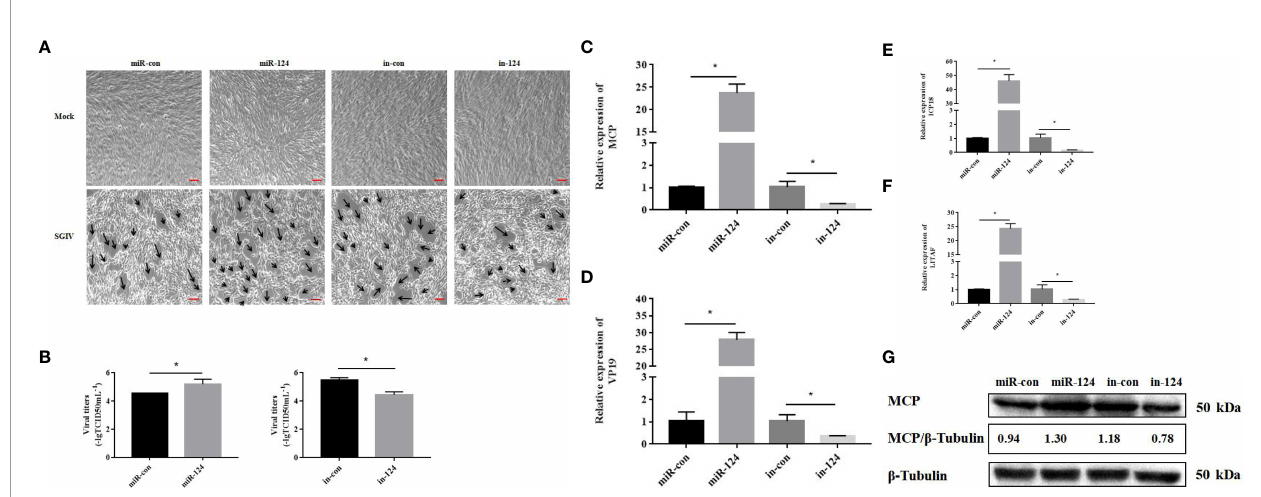
FIGURE 4 | Effect of miR-124 on virus infection and replication. (A) The cytopathic effect (CPE) of Singapore grouper iridovirus (SGIV)-infected miRNA-transfected GS cells, and the black arrows indicate the severity of CPE caused by SGIV infection at 24 h.The scale is 50 m m. (B) The viral titers in each group were measured using the TCID 50 method. Data are presented as mean ± SD, N = 3. (C – F) The expression levels of SGIV genes ( MCP , VP19 , ICP18 , and LITAF ). Data are presented as mean ± SD, N = 4. Compared with the control group, signi fi cant difference of experimental group is indicated with *( P < 0.05). (G) The level of SGIV MCP proteins was detected by Western blotting, the band intensity was calculated, and ratios of target protein/ b -tubulin were assessed by ImageJ software. Control mimics, miR-con; miR-124 mimics, miR-124; control inhibitors, in-con; miR-124 inhibitors,